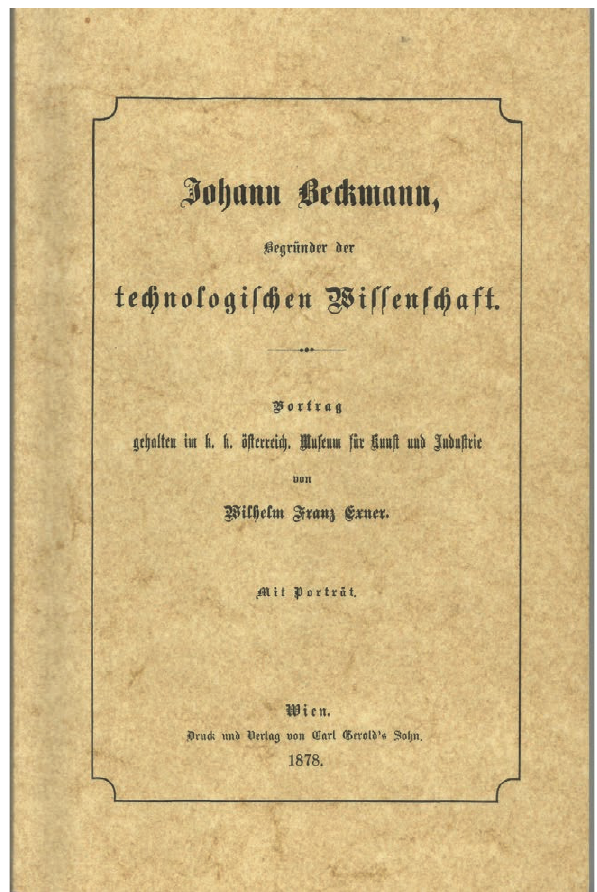
Figure 5. Wilhelm Franz Exner’s essay on life and work of Beck- mann,